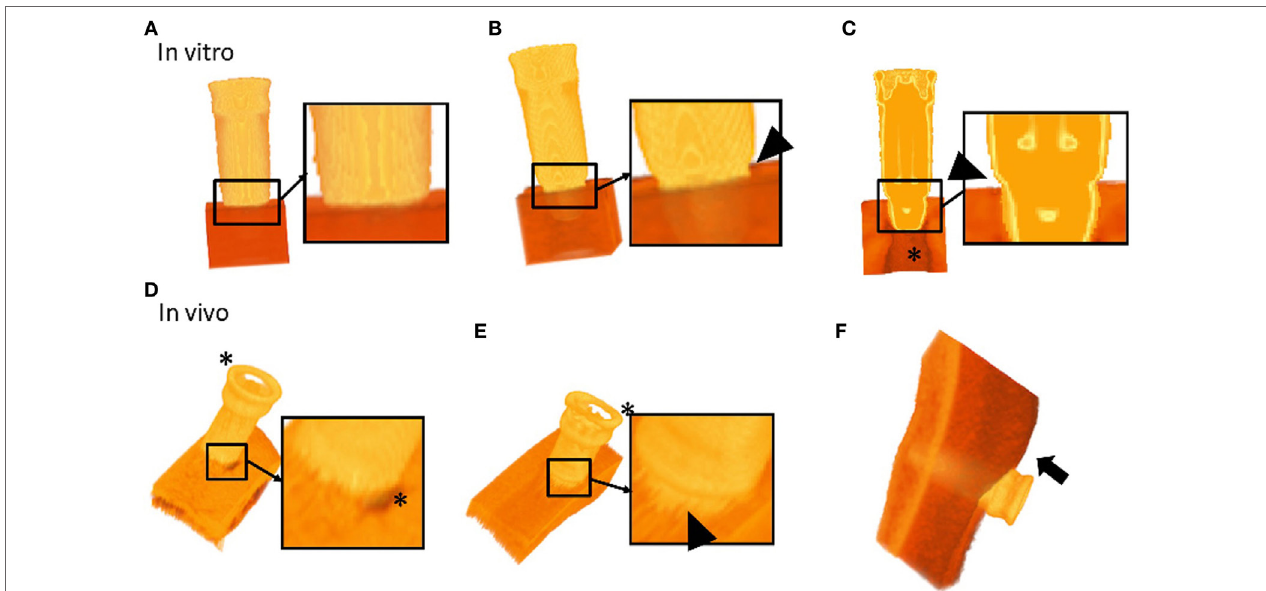
FIgURe 3 | 3D segmented models of bone conduction hearing implants (BCHIs) acquired by cone beam CT imaging. In vitro models: (A) 3D model of a fully inserted BCHI. Full insertion is qualitatively verified by the lack of gap between the implant rim and the artificial bone surface. (B) In contrast, 3D model of a bone surface is visible (arrowhead). (c) A cross-sectional model of a partially inserted BCHI where a gap between the implant rim and artificial bone surface is visible (arrowhead). In vivo models: (D) a 3D model of the implant–skull interface in subject 1 (full insertion). The skin was removed using a filter. (e) A 3D model of the implant–skull interface in subject 4 showing an angulated [full insertion on one side, distance between implant rim and surface on the opposing circumference (arrowhead)]. The skin was removed using a filter. (F) A 3D model of the bone, implant and soft tissue interface for subject 1. Skin sagging was present and can be discerned (arrow). Asterisks (*) indicate softening